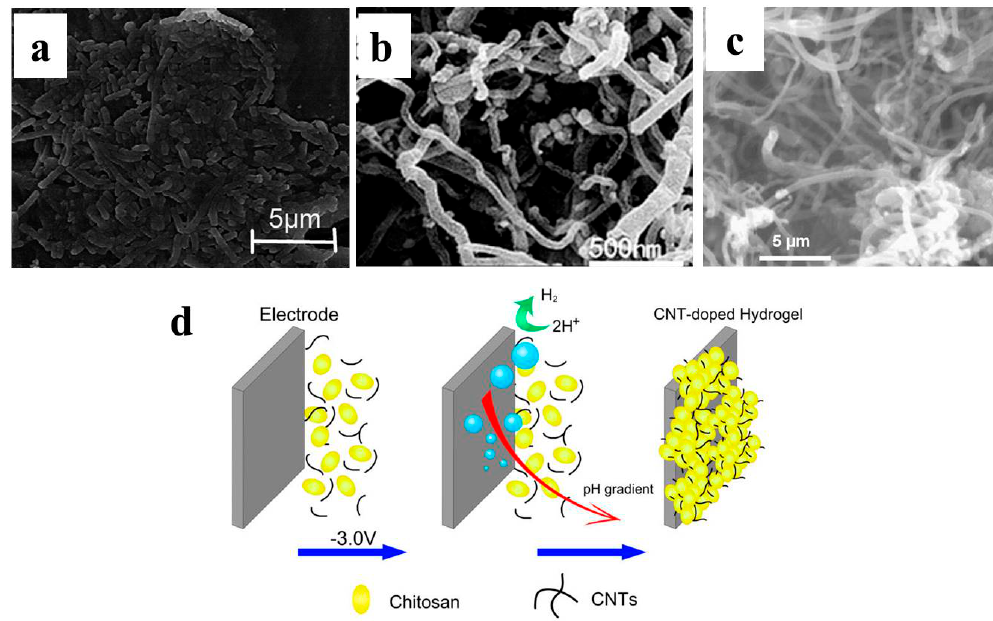
Figure 1. SEM images of 3D electrodes self-assembled on plane electrodes. ( a ) Biofilm formed on rGO-SnO 2 composite on carbon cloth [69]; ( b ) plane graphite with MWCNT/MnO 2 composite [70]; ( c ) carbon paper modified with MWCNT/Pt [71]; and ( d ) CNT/chitosan hydrogel assembled on